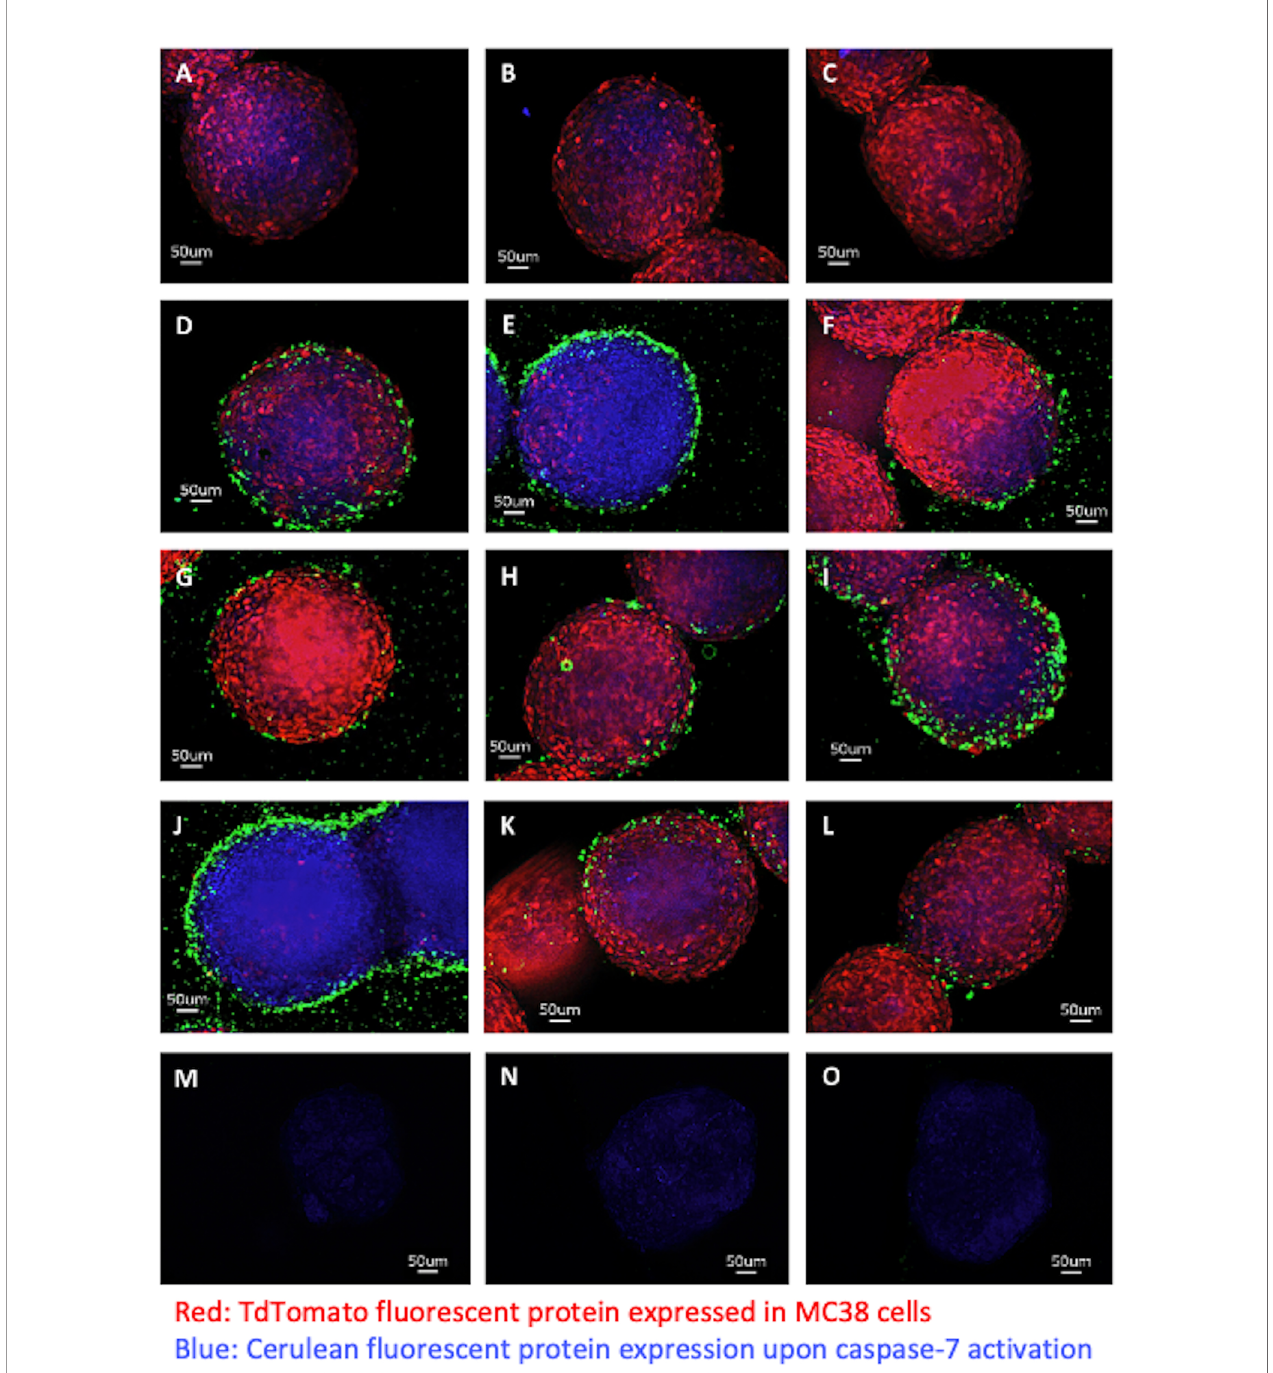
FIGURE 7 | Monoclonal IgM antibodies from L2pB1-derived hybridoma speci fi cally recognize tumor spheroids. 3D tumor spheroids made with MC38 cells (MC38- TdT-C-7-C) express TdTomato when alive and, depending on the expression level of Cerulean, display purple or blue upon cell death induction were incubated with monoclonal IgM antibodies derived from L2pB1 cell hybridoma clones and imaged at 400X magni fi cation: (A) MC38 tumor spheroids stained with anti-mouse IgM- AF488 secondary antibody alone as negative control for non-speci fi c binding; (B, C) MC38 spheroids stained with IgM antibodies from two negative control clones that do not recognize tumor; (D – L) MC38 spheroids stained by monoclonal IgM antibodies from 9 hybridoma clones that showed positive staining. (M – O) Spheroids prepared using normal mouse embryonic fi broblast (MEFs) cells were incubated with the supernatants of each of the L2pB1 hybridoma clones and imaged at 400X magni fi cation. Scale bars for all images represent 50uM. Results are representative of at least three independent